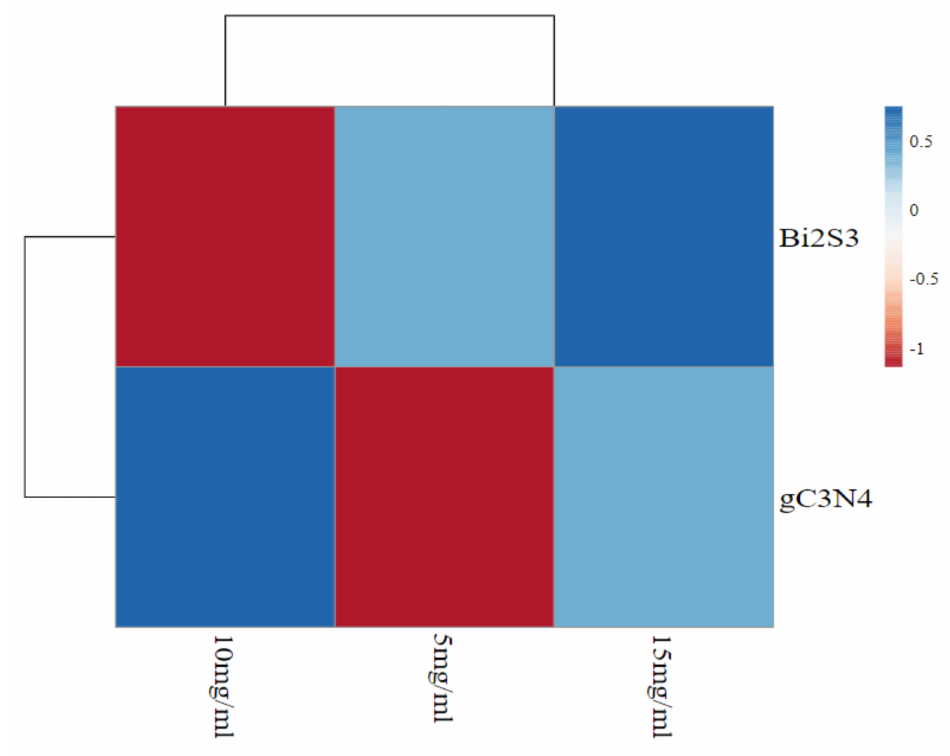
Figure 7. Heatmap showing performances of the two nanoparticle types at different concentration levels. The most significant nanoparticle inhibition of fungal growths was obtained at day 3 after culturing. No significant ( p > 0.05) difference was recorded in the fungal growths inhibited by Bi 2 S 3 nanoparticles at 5 mg/mL and 10 mg/mL concentrations on days 3, 5, 7 and 9, while the least inhibition at 15 mg/mL was recorded on day 9 of observation. Also, with the gC 3 N 4 nanoparticles, the percentage inhibition on day 5 significantly followed performances recorded on day 3 across all the concentration levels, while days 7 and 9 showed no significant differences in the fungal growth inhibition (Table